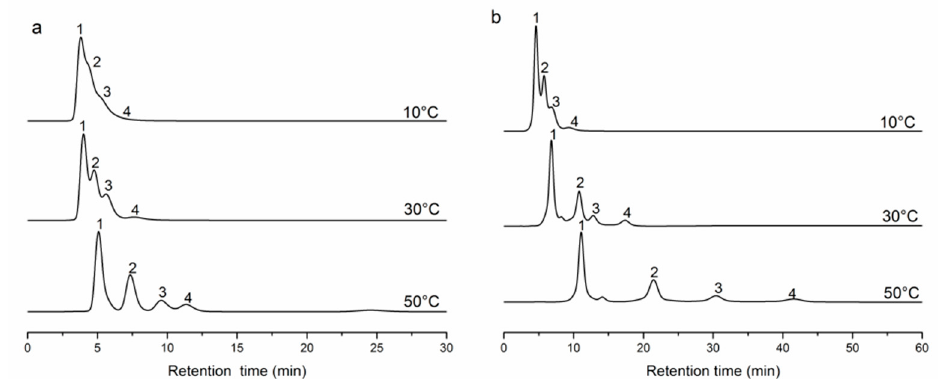
Figure 4. Chromatograms of steroids separated on polymer-modified silica columns. ( a ) Poly(NIPAAm- co -DEAEMA- co -tBAAm)-grafted silica, grafting density is 30%; ( b ) poly(NIPAAm- co -DEAEMA- co -tBAAm)-grafted silica, grafting density is 50%. The mobile phase used was 10 mM pH 7 phosphate buffer solution; flow rate, 0.1 mL/min; detection wavelength, 254 nm. Peaks: 1, hydrocortisone; 2, dexamethasone; 3, hydrocortisone butyrate; 4, prednisolone acetate.